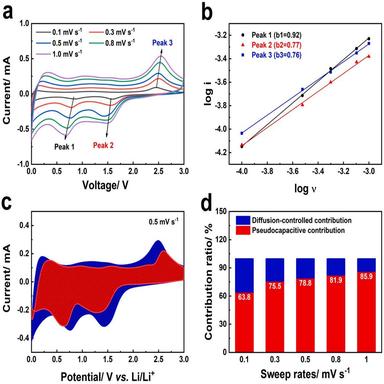
(a) CV curves at different sweep rates, (b) the b-values, (c) separation of diffusion and capacitive capacity at the sweep rate of 0.5 mVs−1, (d) the contribution ratios of the diffusion-controlled and capacitive charge vs. the scan rate.